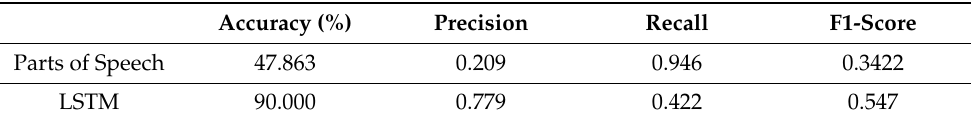
Table 1. Results from the test set (BB/WJ combined) when using WA/WC combined as the training and validation data. Accuracy (%) Precision Recall F1-Score Parts of Speech